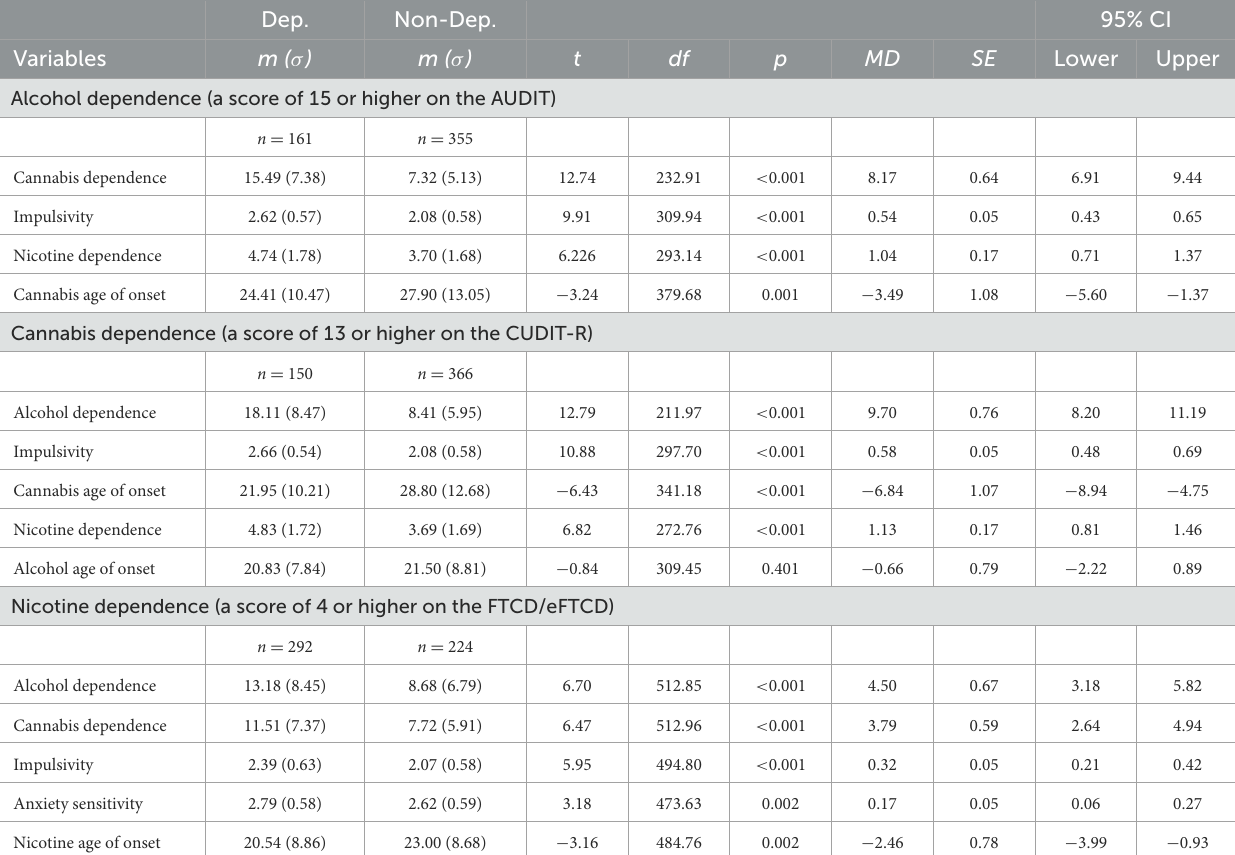
TABLE 4 Post-hoc t-tests comparing significant predictors between dependent and non-dependent users. Dep. Non-Dep. 95% CI Variables Lower